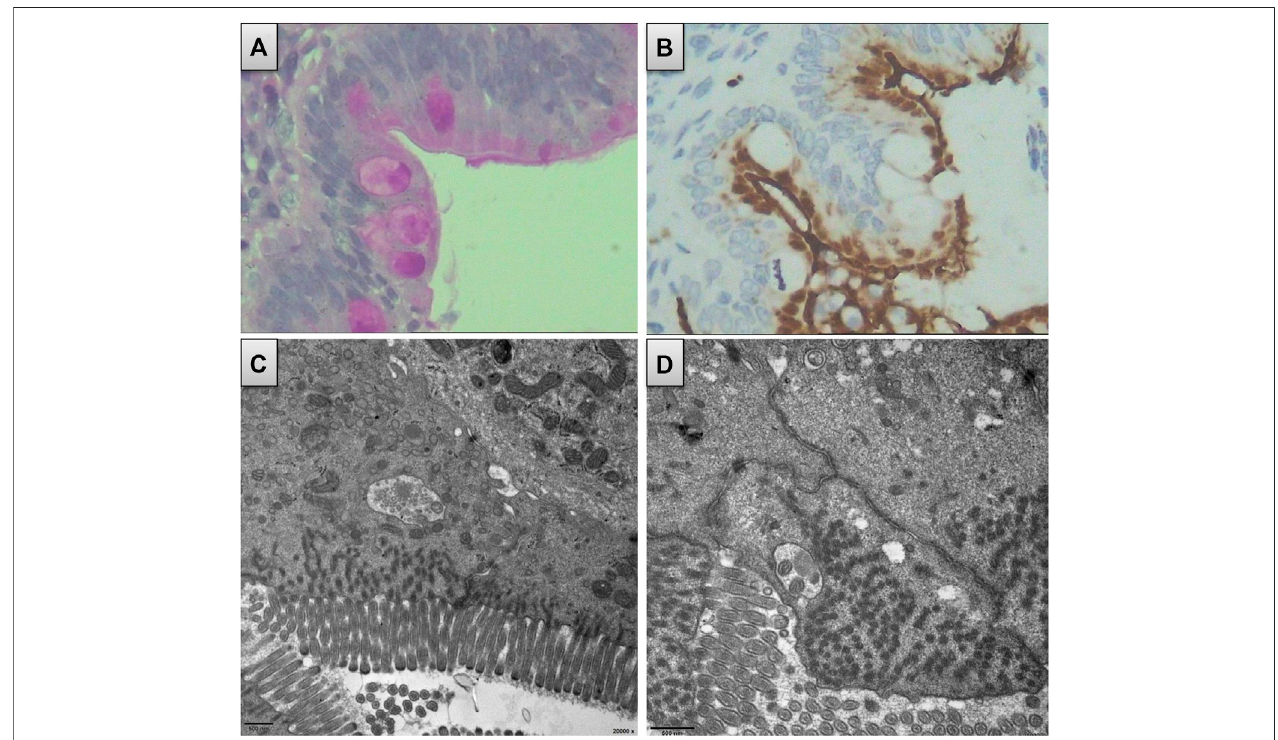
FIGURE3| Duodenum biopsyrevealeddecreasedmicrovillusandlocallesionofmicrovillusinclusion. (A) Decreasedmicrovillusandobscurebrushborderappear in immunohistochemistry using PAS. (B) Obscure brush border of microvillus and internalized appearance using CD10 staining. (C) and (D) Local lesion of microvillus inclusion from the electron